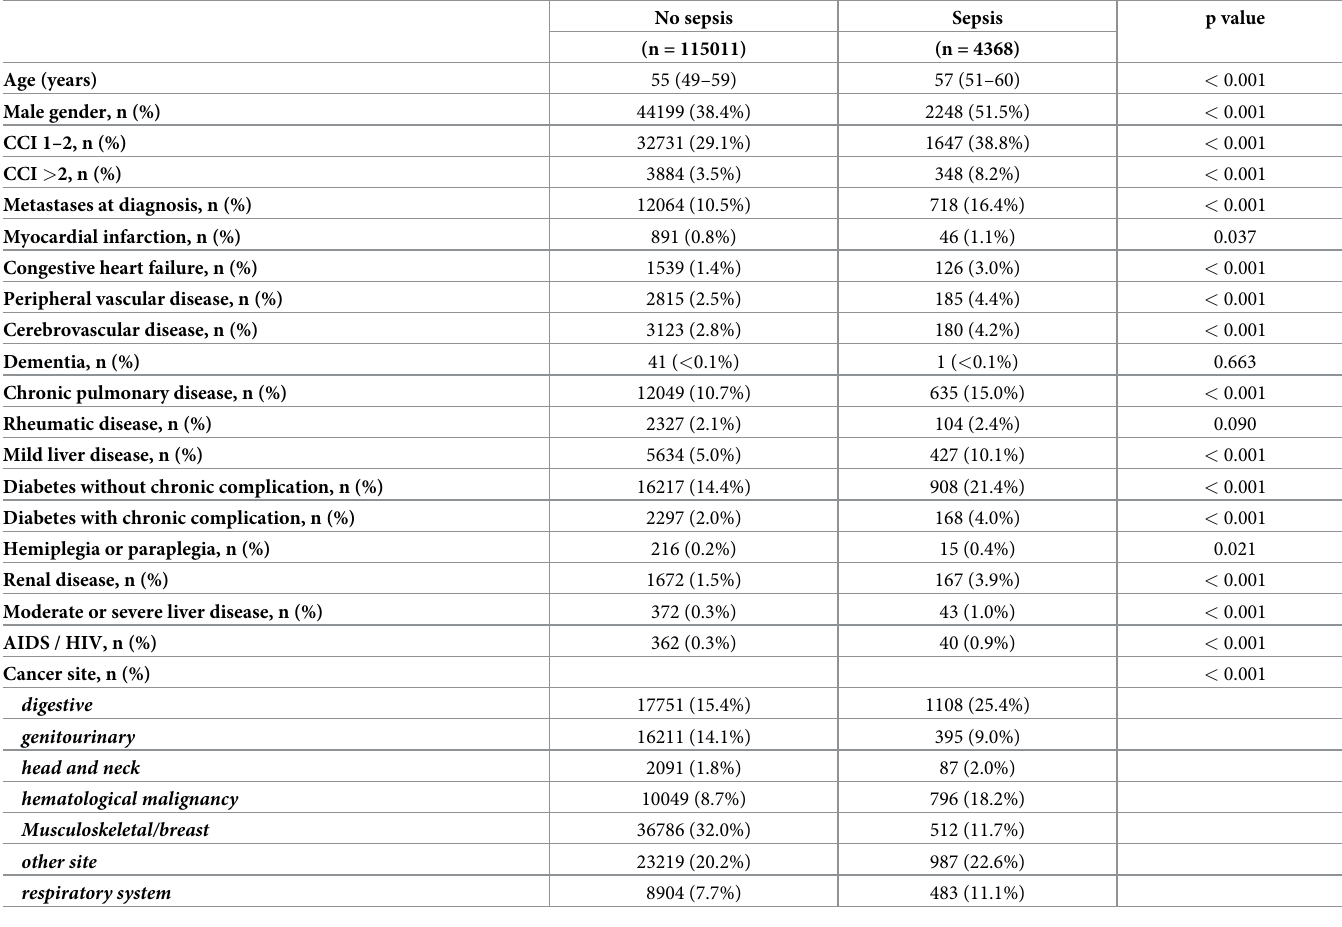
Table 2. Univariate analysis comparing cancer patients who did and did not develop sepsis within 1 year of cancer diagnosis.